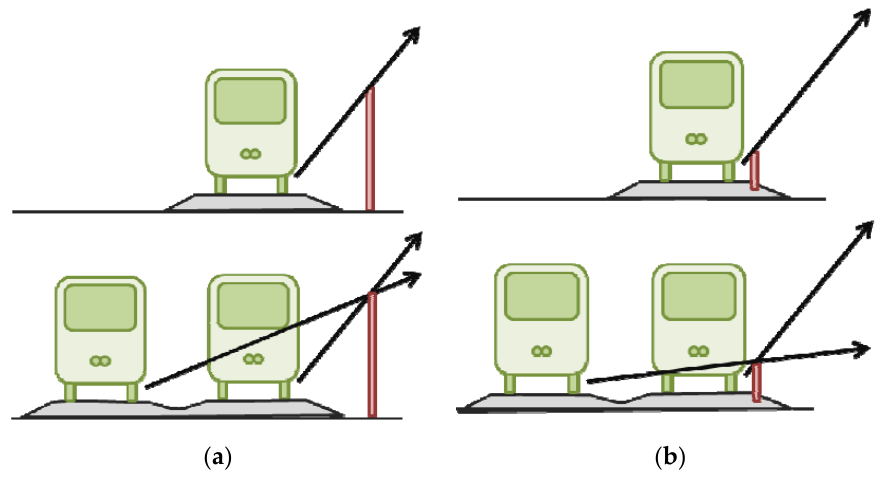
Figure 8. Schematics of conventional ( a ) and low-close noise ( b ) barriers [2].